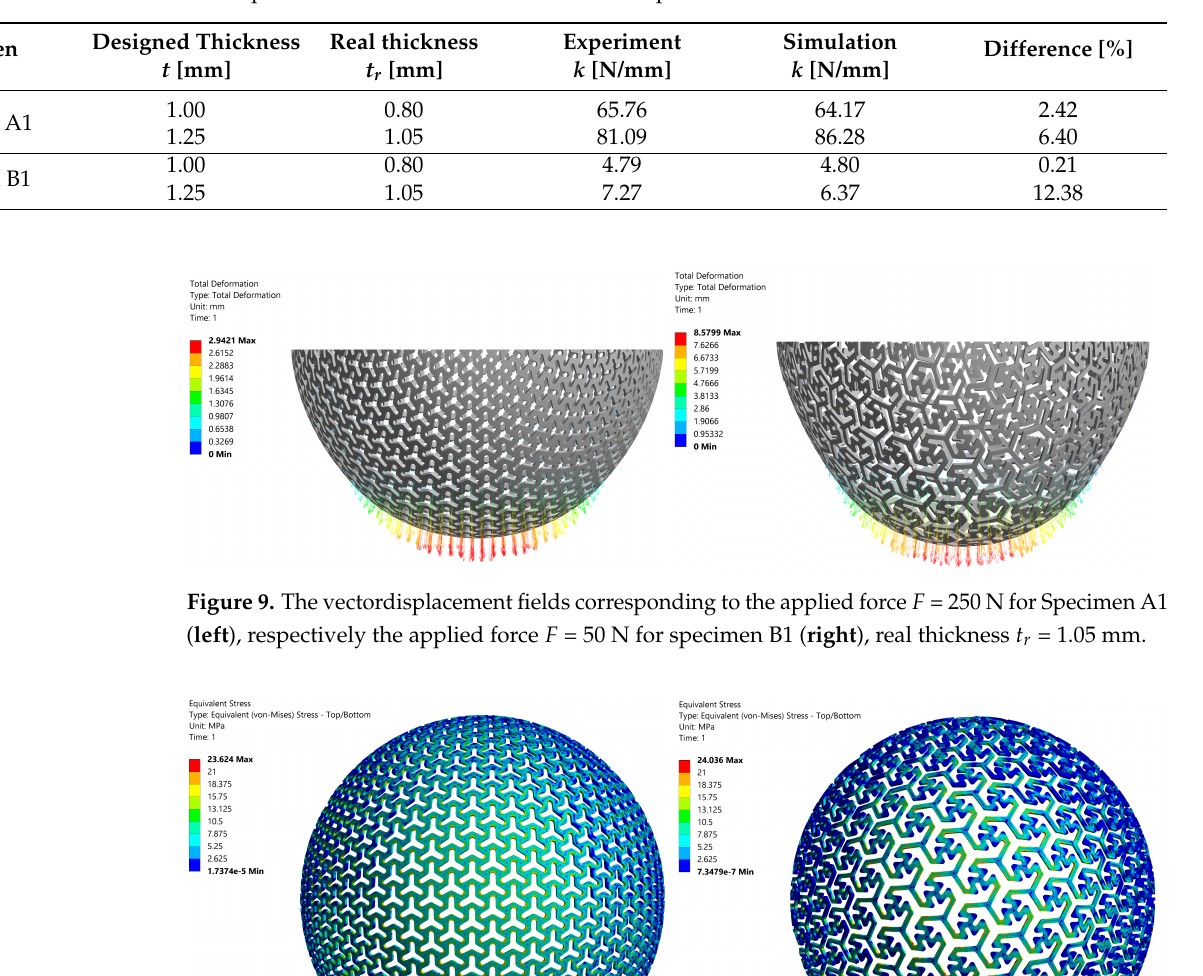
Table 6. Comparison of determined stiffness k from experiment and simulation.